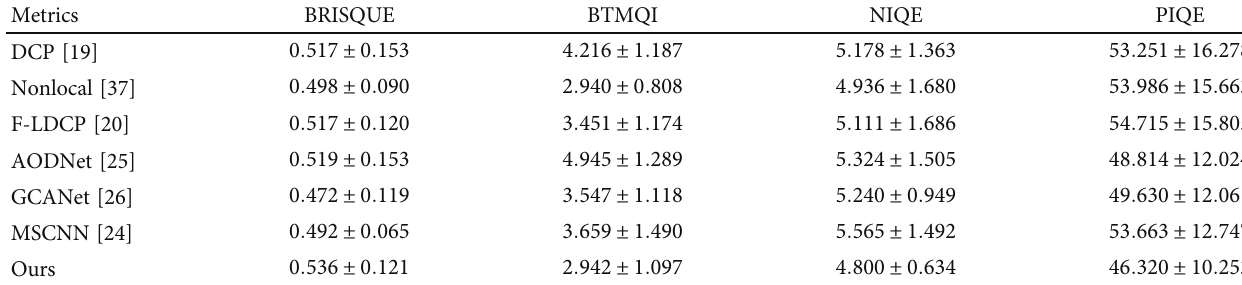
Table 2: Quantitate comparison on real hazy